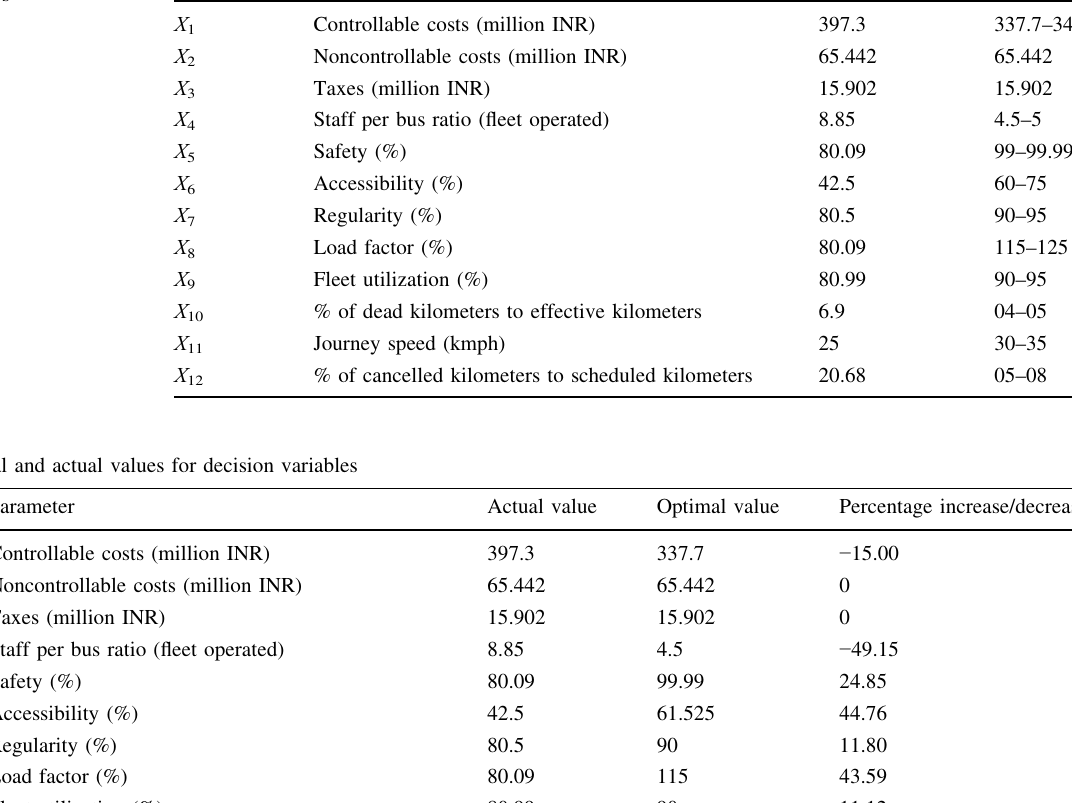
Table 7 Threshold values for